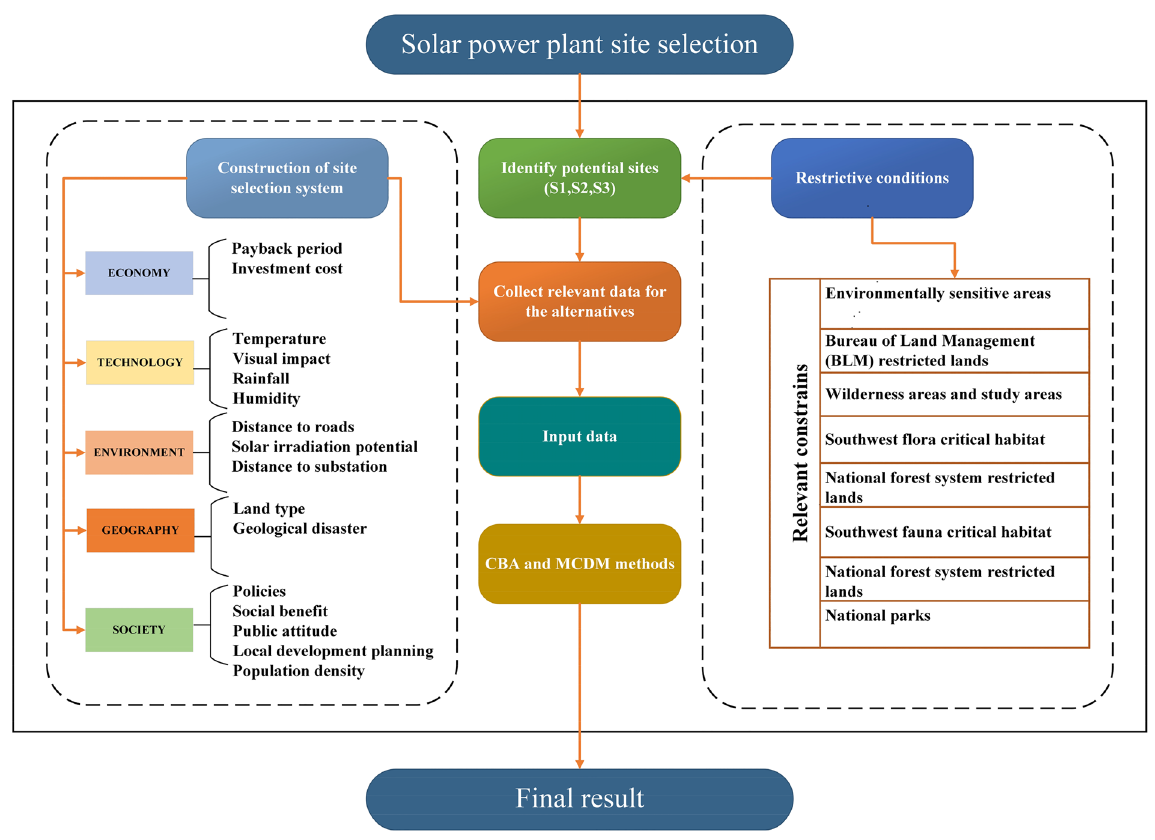
Figure 1. Solar power plant site selection